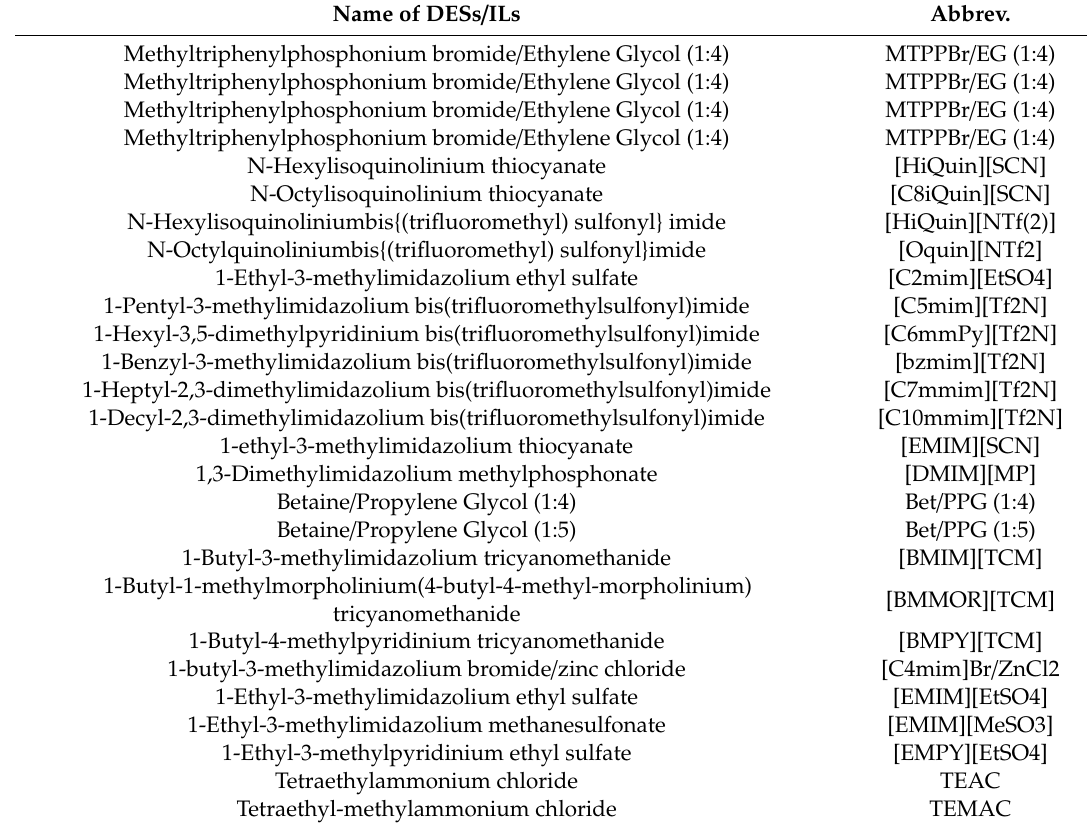
Table 10. List of full names of ILs and DESs and their abbreviation used in Table 9. Name of DESs / ILs